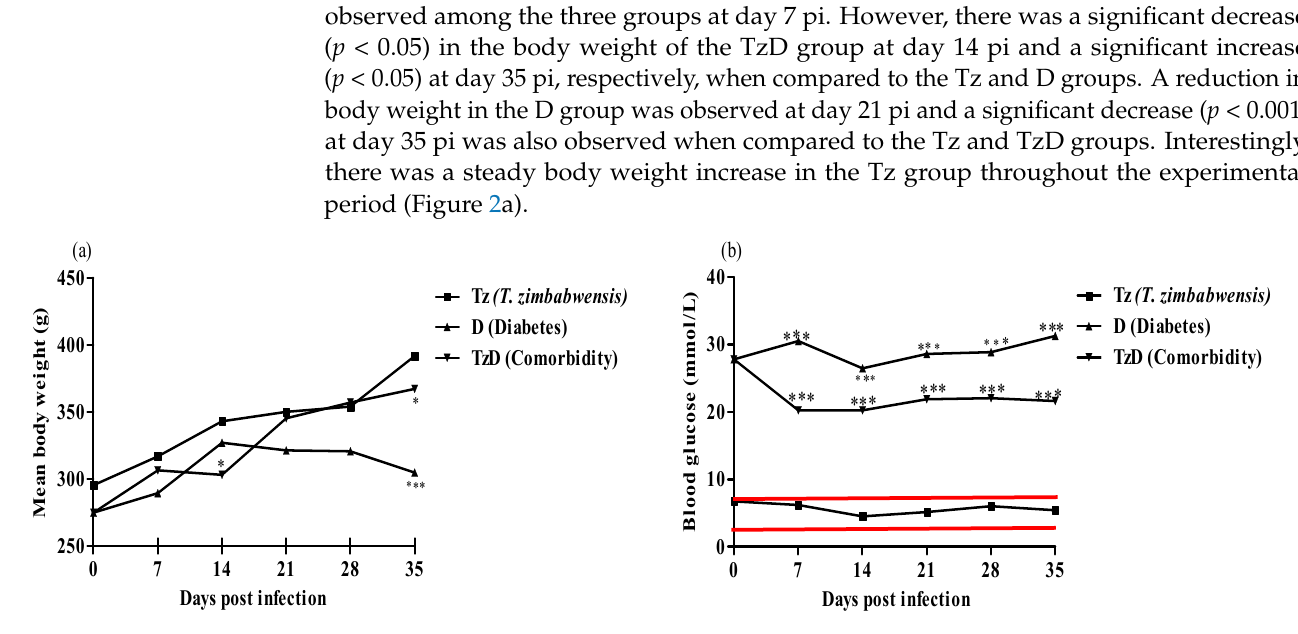
Figure 2. Mean body weight ( a ) and blood glucose concentration ( b ) in male Sprague Dawley rats that were; comorbid with type 2 diabetes mellitus (TzD), diabetic (D) and infected with Trichinella zimbabwensis (Tz). Horizontal redlines depicts the range of reference values for blood glucose (4.70–6.70) in male Sprague Dawley rats He et al. [27]. Values are presented as means ( n = 6 in each group) and asterisk represent significant differences between the groups (* p < 0.05, ** p < 0.01, *** p < 0.001). Blood glucose results from this study were compared to the reference values by He et al. [27]. Blood glucose were within the reference value range during the study